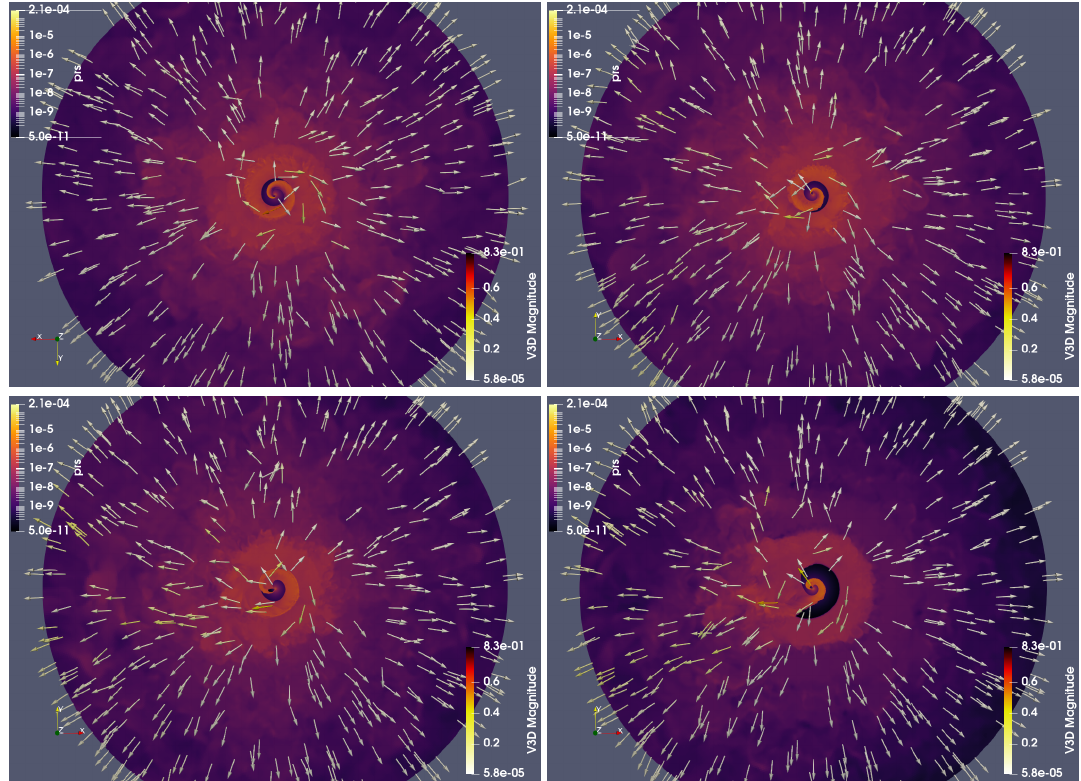
Figure 3. The same as in Figure 1 but for